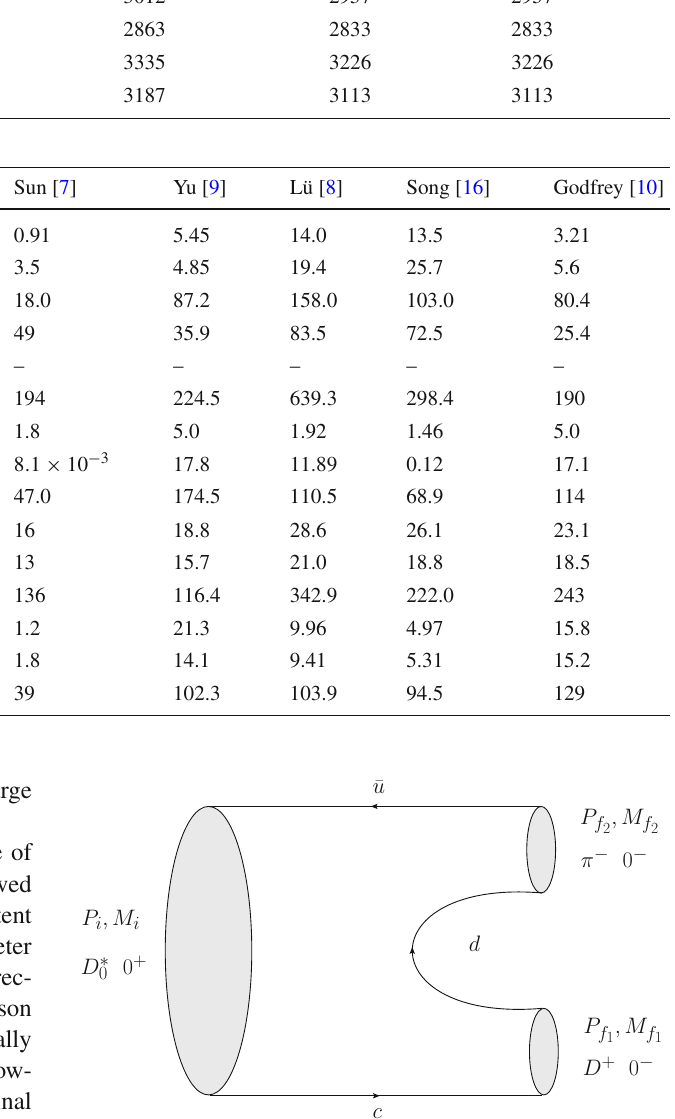
Fig. 1 Feynman diagram for the decay channel D ∗